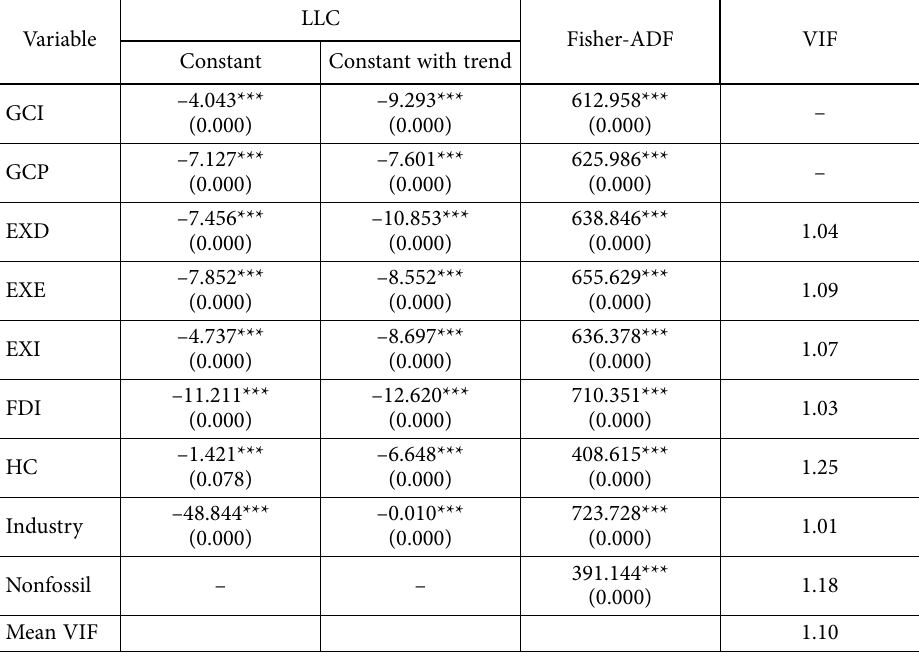
Table 2. Panel unit root and multicollinearity tests